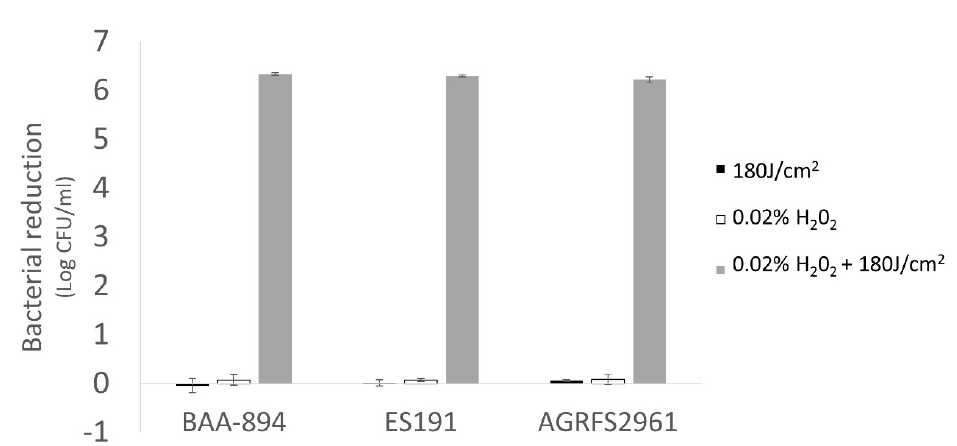
Figure 5. The combined effect of 0.02% H 2 O 2 and 180 J/cm 2 of light dose on stationary phase cells. 3.6. The Combined Effect of Sublethal Hydrogen Peroxide (H 2 O 2 ) and Light Inactivation against